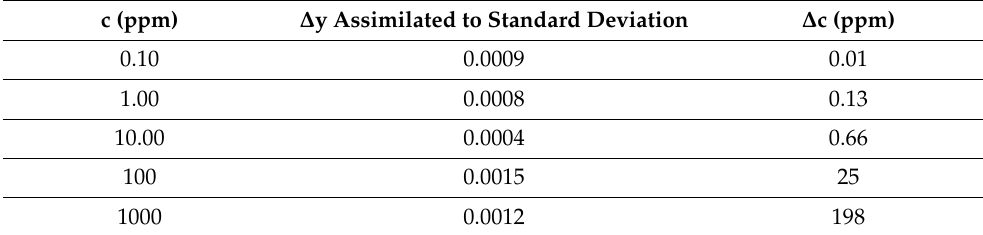
Table 2. Estimated errors on the gliadin content using the LSPR peak intensity measurement. c (ppm)